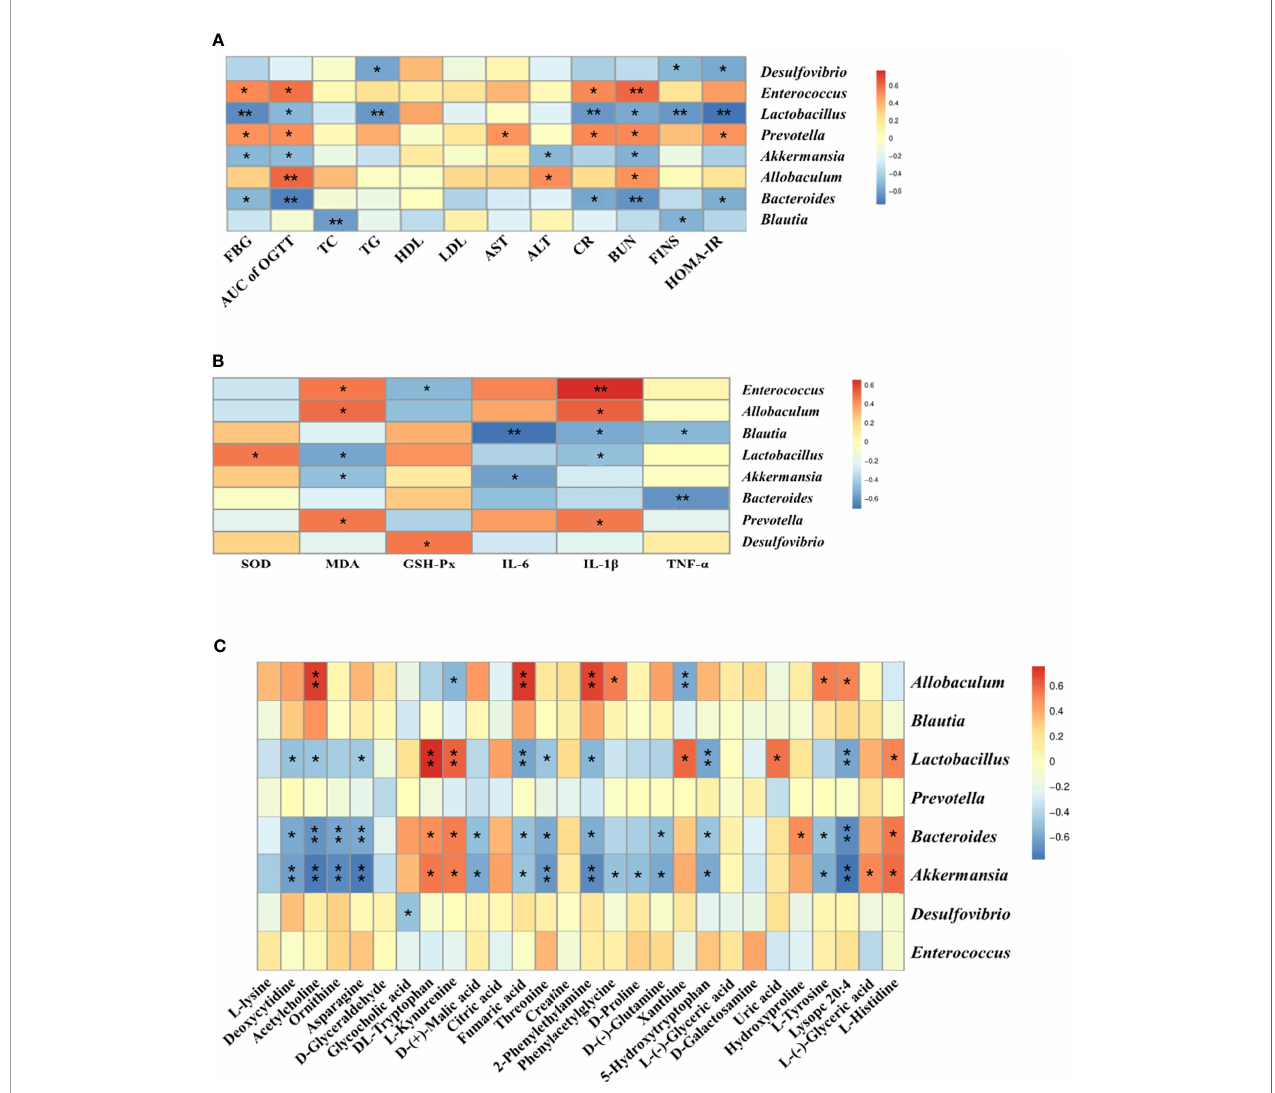
FIGURE 5 | Correlation analysis of physiological data, oxidative stress and in fl ammatory factors, untargeted metabolomics and 16S rRNA sequencing. Correlations between physiological data and gut microbiota (A) , between oxidative stress and in fl ammatory factors and gut microbiota (B) and between untargeted metabolomics and gut microbiota (C) were analyzed using spearman ’ s analysis (heatmap). X-axis represents the physiological indices (A) , oxidative stress and in fl ammatory factors (B) and differential metabolites in the serum (C) . Y-axis represents the gut microbiota with differential abundance. The colors of grids represent the correlation analysis value of spearman ’ s correlation analysis. Grids in red indicate positive correlations (correlation analysis value more than 0.1), while grids in blue indicate negative correlations (correlation analysis value less than -0.1). Color coding scale indicates the correlation analysis value from heatmap, the deeper red or blue indicates higher correlation values. * p < 0.05 between physiological data, oxidative stress and in fl ammatory factors, differential serum metabolites and gut microbiota. ** p < 0.01 between physiological data, oxidative stress and in fl ammatory factors, differential serum metabolites and gut